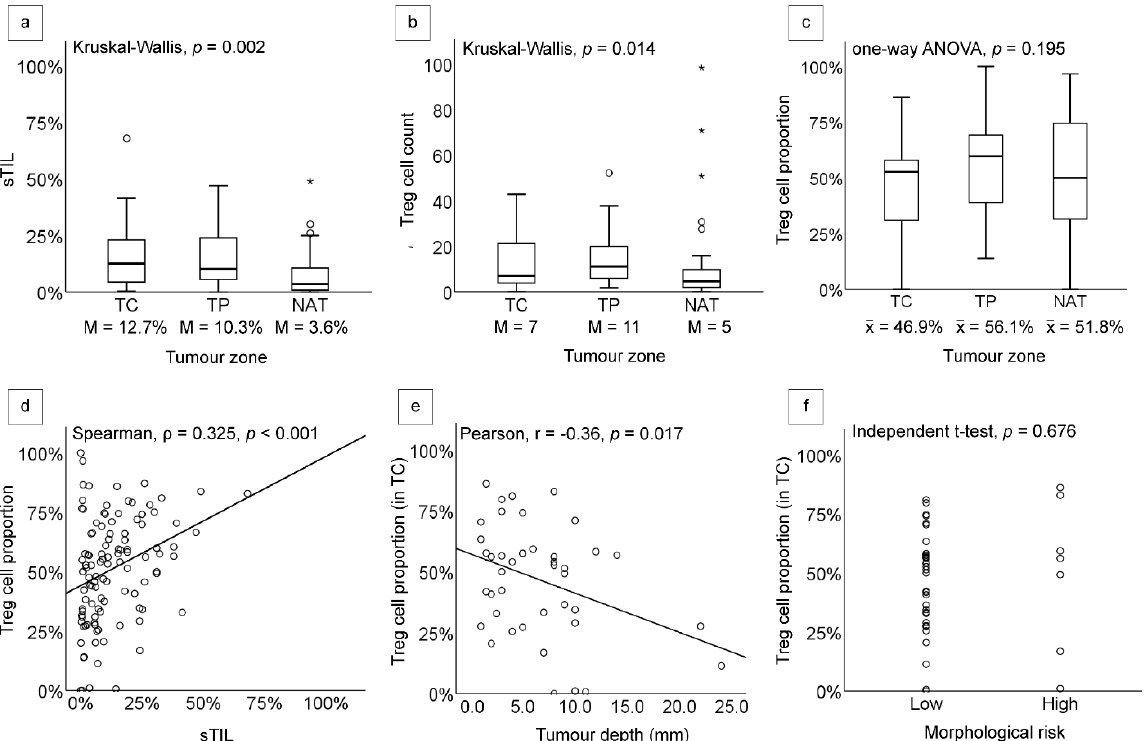
Figure 3. Boxplots and scatterplots showing the associations between observed variables in tumour centre (TC), tumour periphery (TP), and the normal adjacent tissue (NAT): ( a ) The proportion of sTILs was highest in the TC, and a significant difference was found between the sTIL medians of NAT and TP ( p = 0.012), as well as between NAT and TC ( p = 0.004); ( b ) The difference in Treg cell counts was statistically significant between NAT and TP ( p = 0.009), as well as between NAT and TC ( p = 0.018); ( c ) Treg cell proportions between the three tumour zones showed no significant difference; ( d ) Significant positive correlation was observed between sTIL and Treg cell proportion ( ρ = 0.325, p < 0.001); ( e ) Pearson correlation showed a significant negative correlation between tumour invasion depth and Treg cell proportion in the TC (r = − 0.362, p = 0.017); ( f ) No significant difference of Treg cell proportion was observed between morphological risk in the TC ( p = 0.676). In the boxplots ( a , b ), circles represent potential outliers while * (stars) represent true outliers. x ̅ = mean, M = median. Table 1. Summary of the associations between observed parameters. sTILs Median p Value p (Cell)